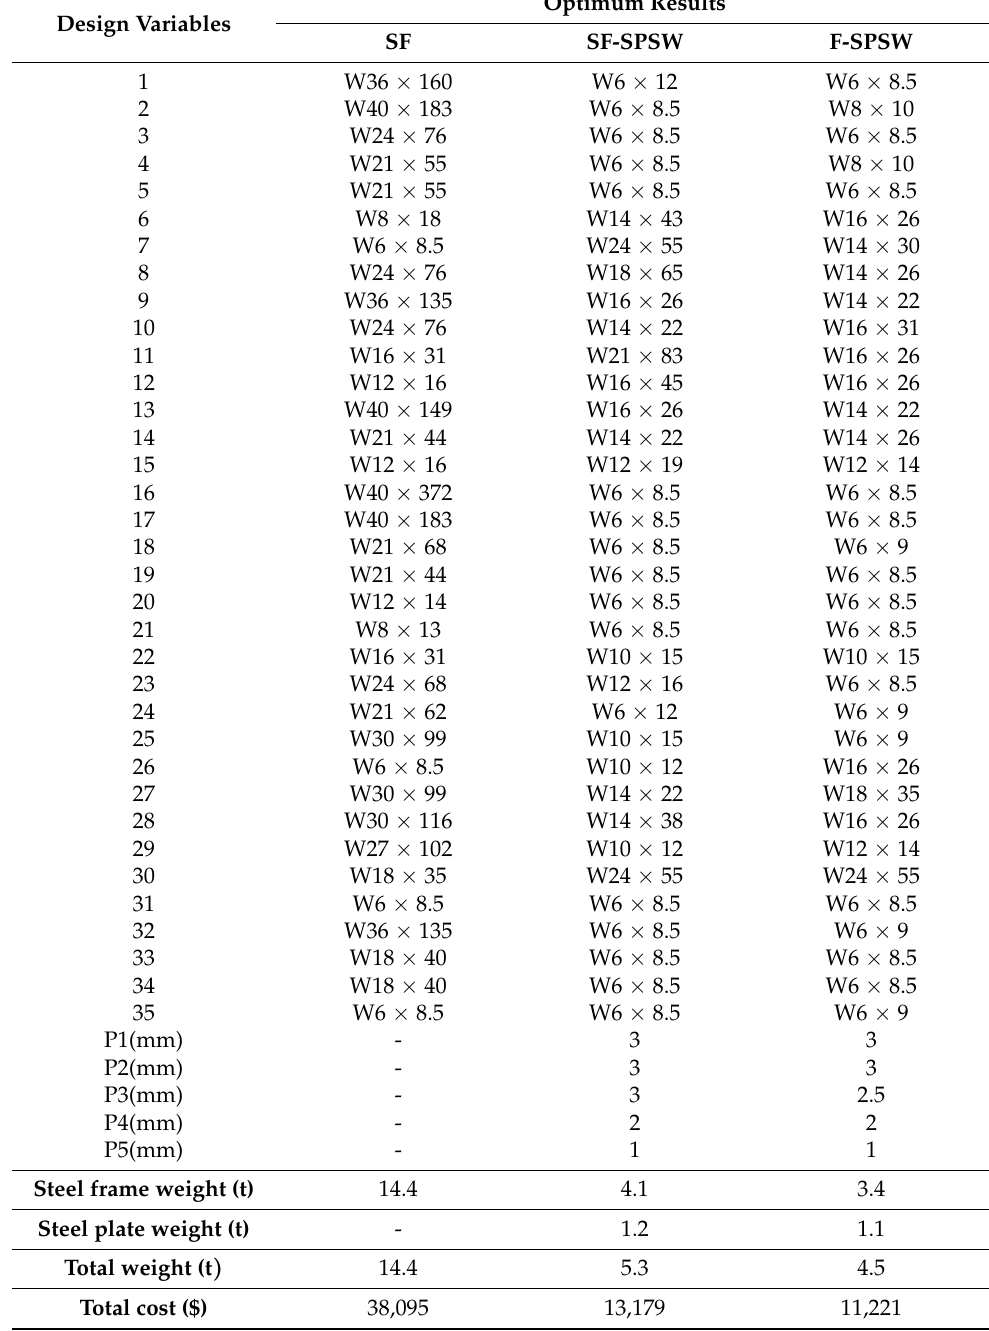
Table 3. Results of SF and